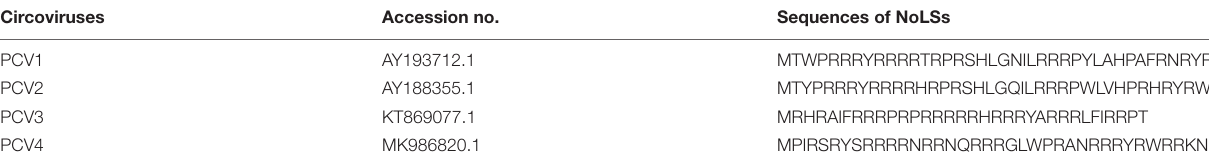
TABLE 1 | The nucleolar localization signals (NoLSs) of Cap protein from different porcine circovirus genotypes. Circoviruses Accession no.